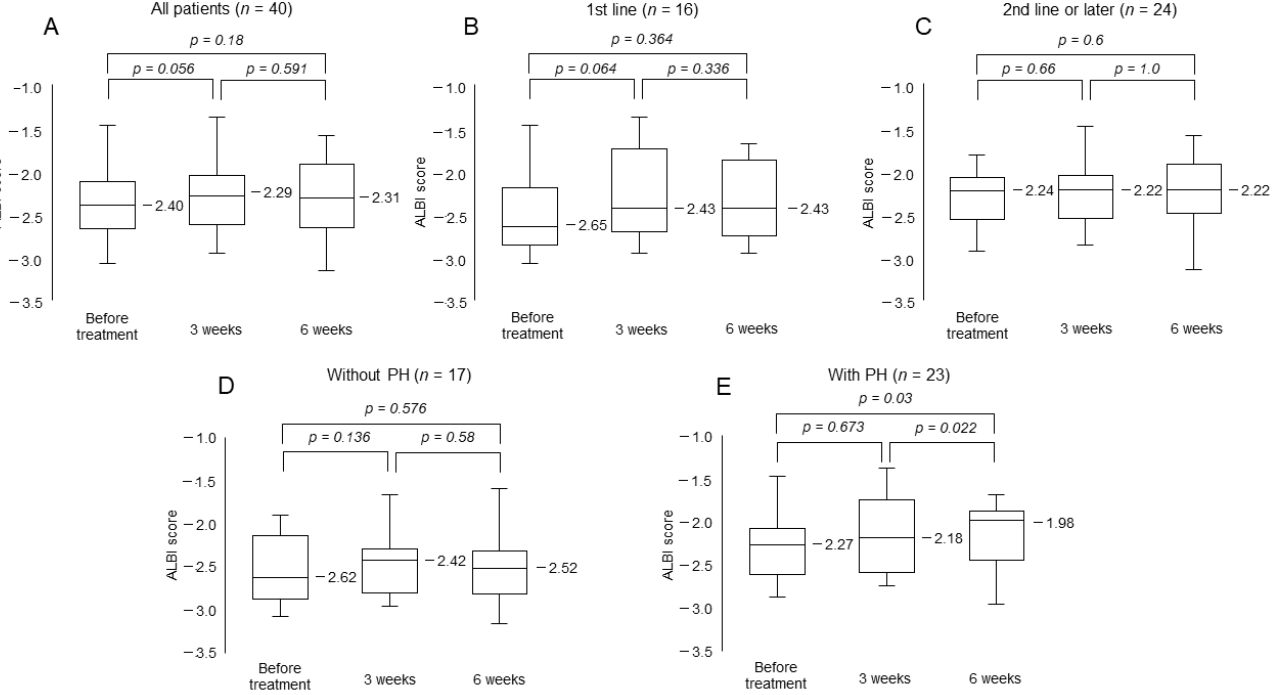
Figure 3. Change in albumin–bilirubin (ALBI) score. ( A )All patients. ( B ) Patients treated as first-line treatment. ( C ) Patients treated as second-line or later treatment. ( D ) Patients without portal hypertension (PH). ( E ) Patients with PH.